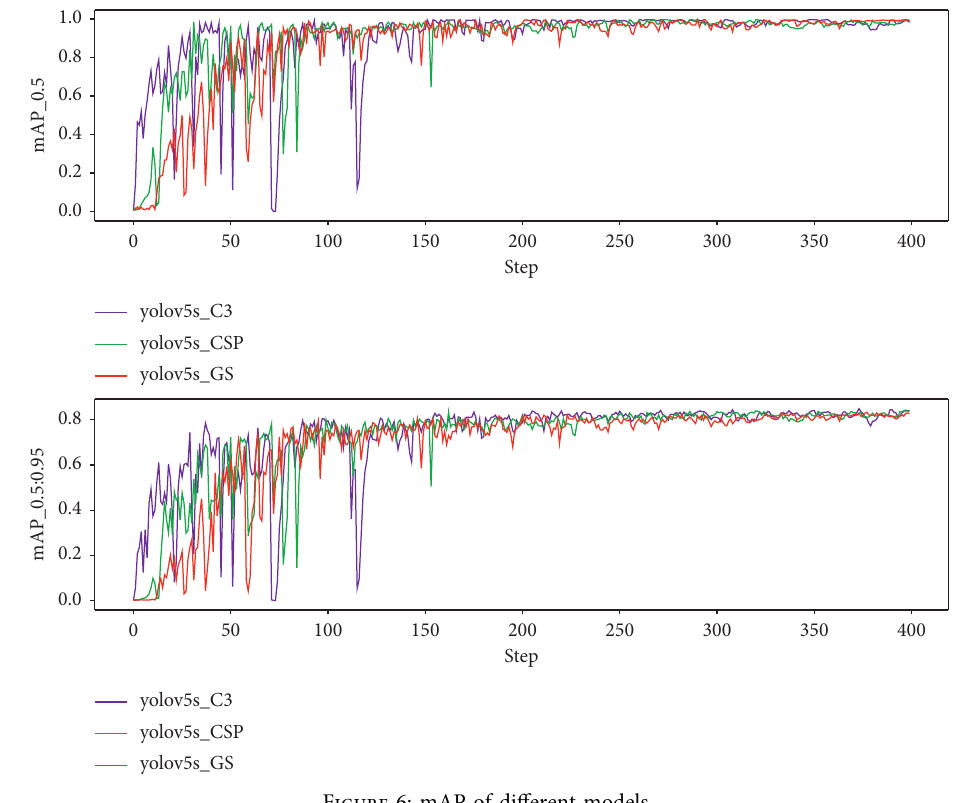
Figure 6: mAP of different models.